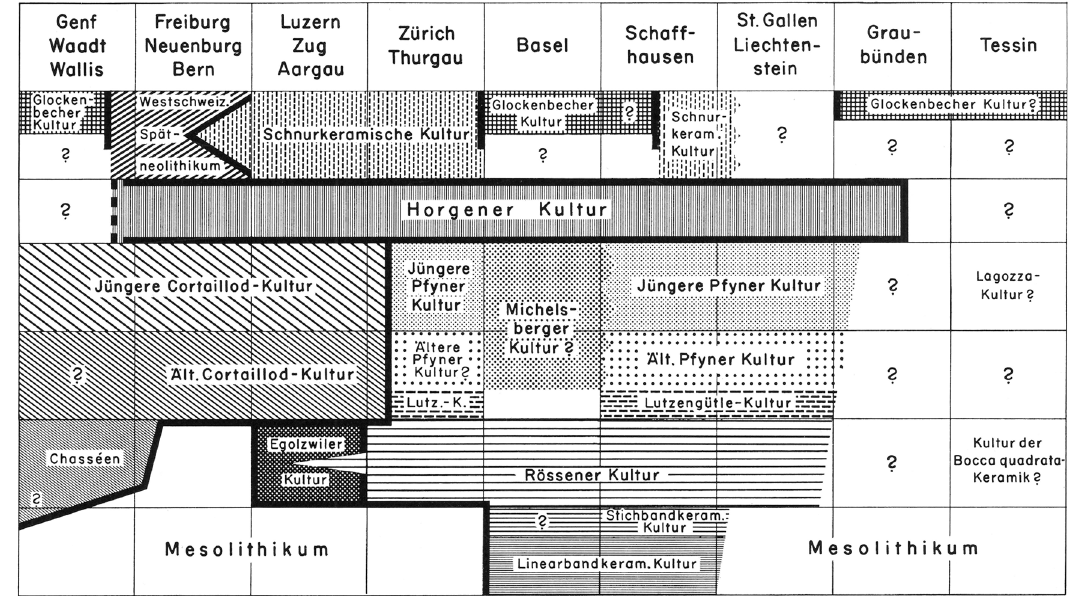
Figure 1: Vogt ’ s ( 1964 ) Chronology Scheme of Neolithic Cultures in